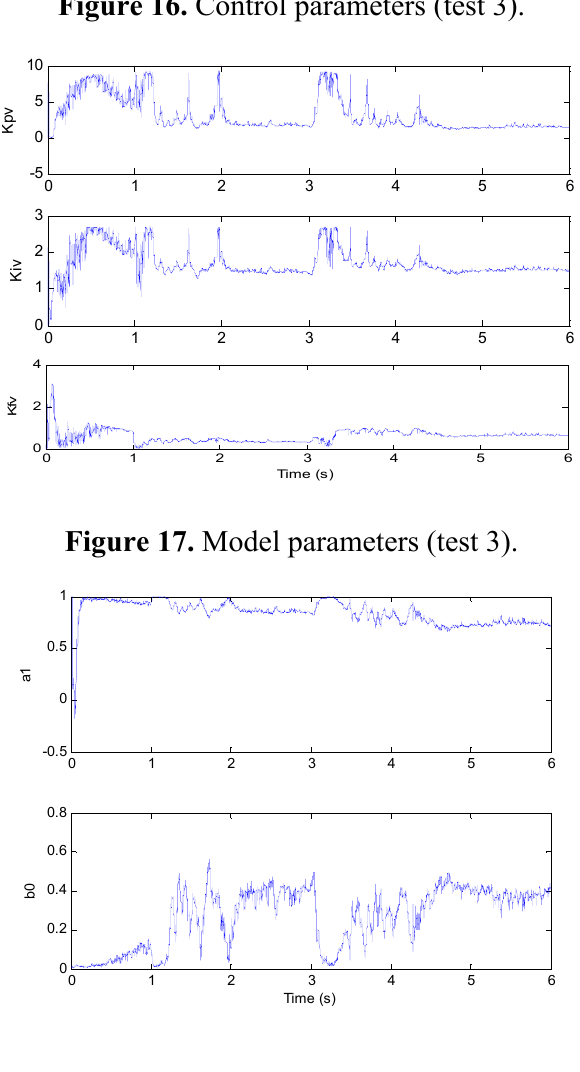
Figure 16. Control parameters (test 3).